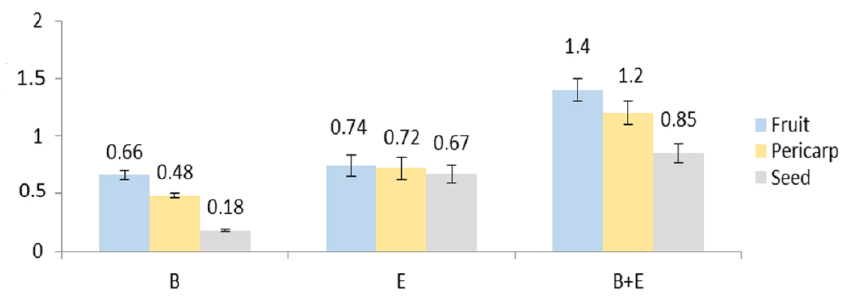
Figure 4. Contents of eleutherosides (mg/g extract): B—eleutheroside B, E—eleutheroside E, B + E—sum of eleutheroside B and eleutheroside E.